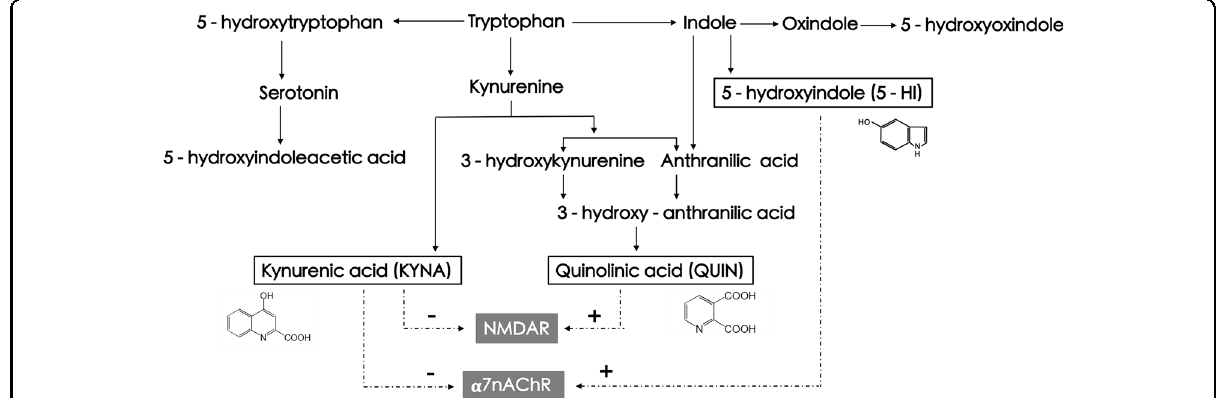
Fig. 1 Abbreviated tryptophan pathway and the presumed neuroactive metabolite effects on α 7nAChR and NMDAR. Dotted line refers to hypothetical effects based on preclinical data. Positive signs show the agonist effect and negative signs show the antagonist effect 17,49,89,90